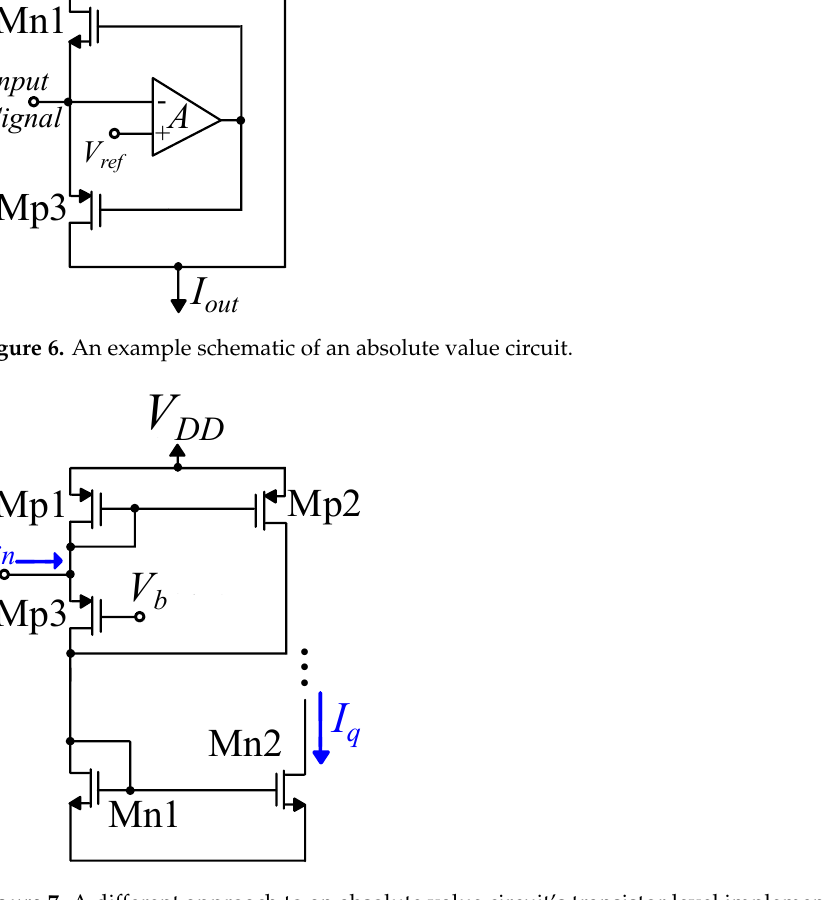
Figure 7. A different approach to an absolute value circuit’s transistor level implementation.